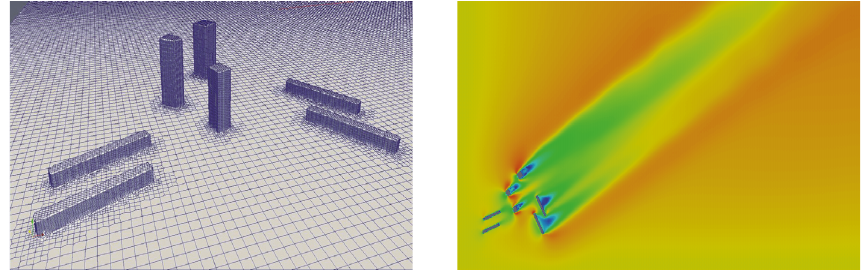
Figure 1: An urban topography composed by three skyscrapersand four elongated buildings (left) and horizontal snapshots of the associated joint wake